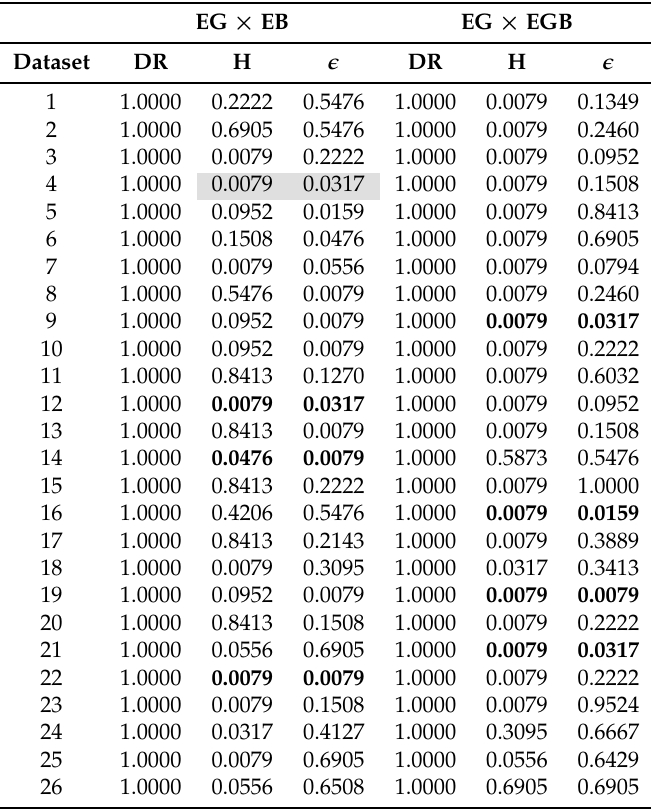
Table 3. MAMH multi-objective